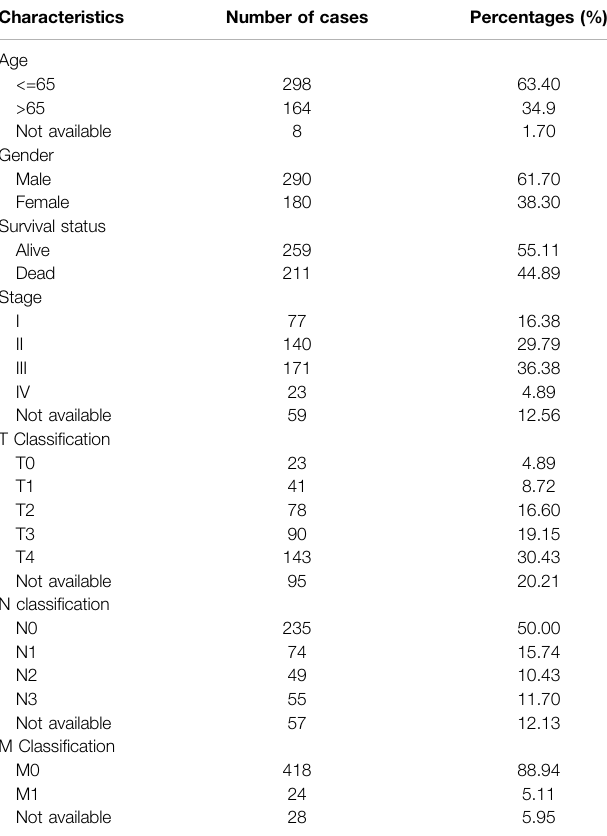
TABLE 1 | The clinical characteristic information of the melanoma patients in TCGA (470 in total).